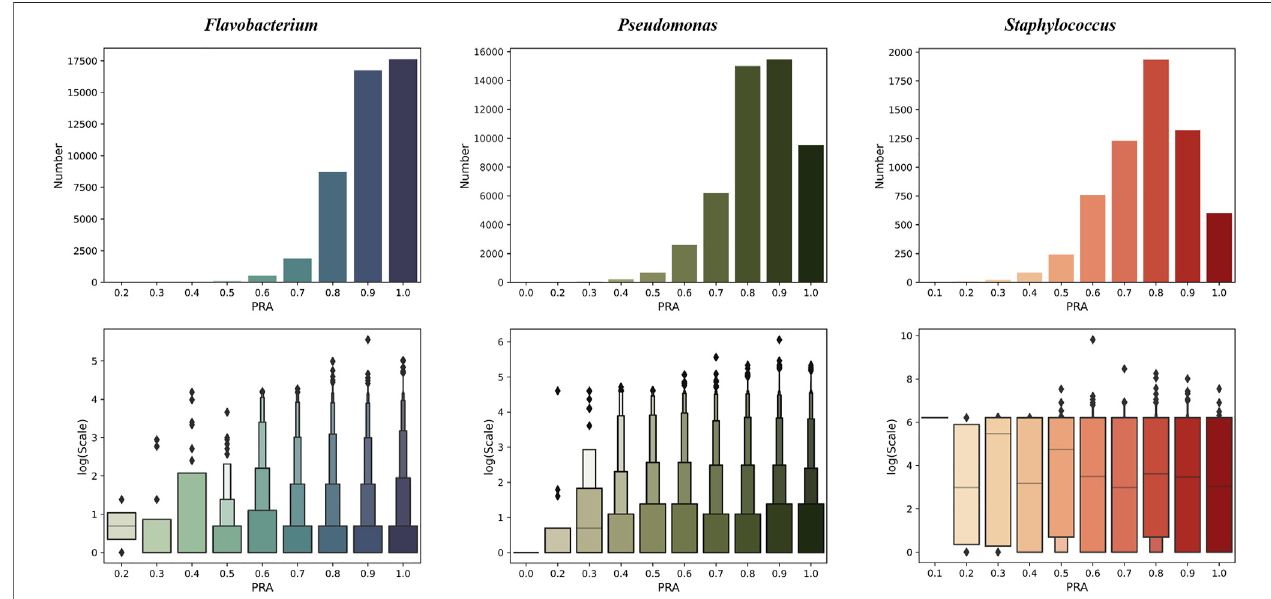
FIGURE 3 | The performance of PPA-GCN on three genera (in terms of the PRA) and the node scale distribution of the node set at each PRA level (10% as one level). From left to right are Flavobacterium, Pseudomonas, and Staphylococcus .